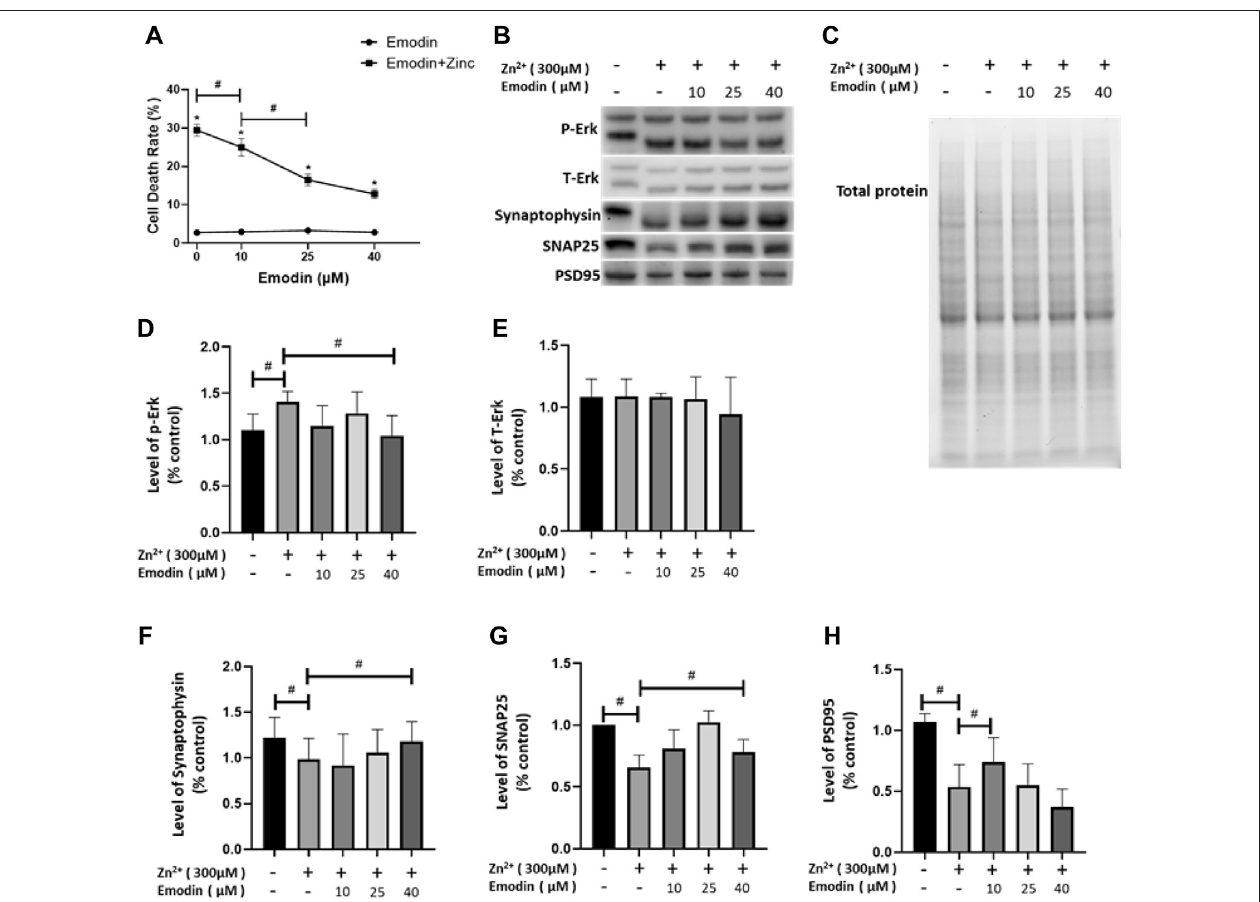
FIGURE 1 | Emodin attenuates cell death, reverses the activation of phosphorylated ERK1/2 and affects synapse-related proteins in SH-SY5Y cells exposed to 300 μ M zinc sulfate. (A) The cell death rate determined using the CCK-8 kit. (B) Immunoblot image of phosphorylated ERK1/2 (p-Erk) and total ERK1/2 (t-ERK), synaptophysin, SNAP25, and PSD95 in SH-SY5Y cells. (C) Stain-free image of SH-SY5Y cell lysate. (D, E) Immunoblot analysis of phosphorylated ERK1/2 and total ERK1/2. (F – H) Immunoblot analysis of synapse-related proteins. Different concentrations of emodin (10, 25, and 40 μ M) were applied. One-way ANOVA and Bonferroniposthocanalysis,# p < 0.05;Welch ’ s t test,* p < 0.05vs.SH-SY5Ycellstreatedwithemodinonly;ns,notsigni fi cant.Dataarepresentedasthemean±SEM.